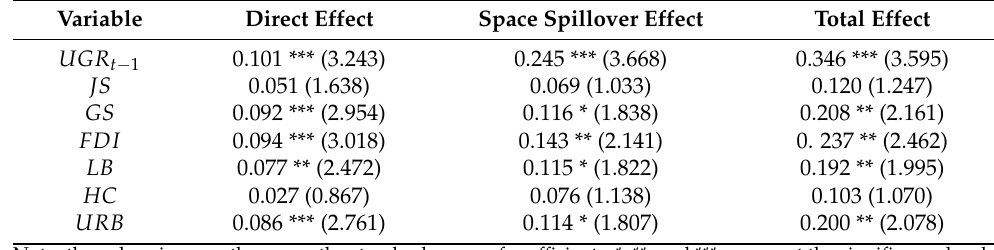
Table 8. Robustness